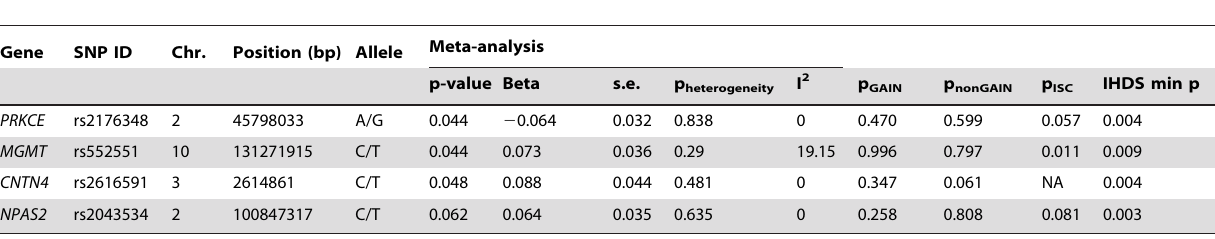
Table 4. Four SNPs from the meta-analysis of 66 SNPs using GAIN, nonGAIN, and ISC GWAS datasets.